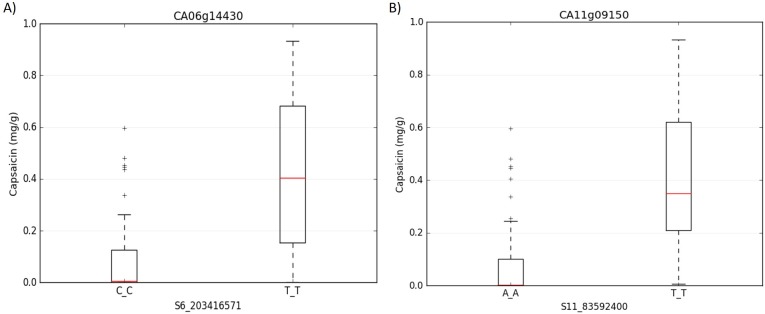
Allelic effect of two significantly associated SNPs markers for capsaicin content in C. annuum.Each plot is labeled with the SNP position in the X-axis. Y-axis represents the values for capsaicin levels (mg·g-1) in pepper powder from dried green fruit. Boxplot A) shows the effect of SNP marker in locus CA06g14430 on chromosome 06, whereas boxplot B) shows the effect of SNP marker in locus CA11g09150 on chromosome 11.